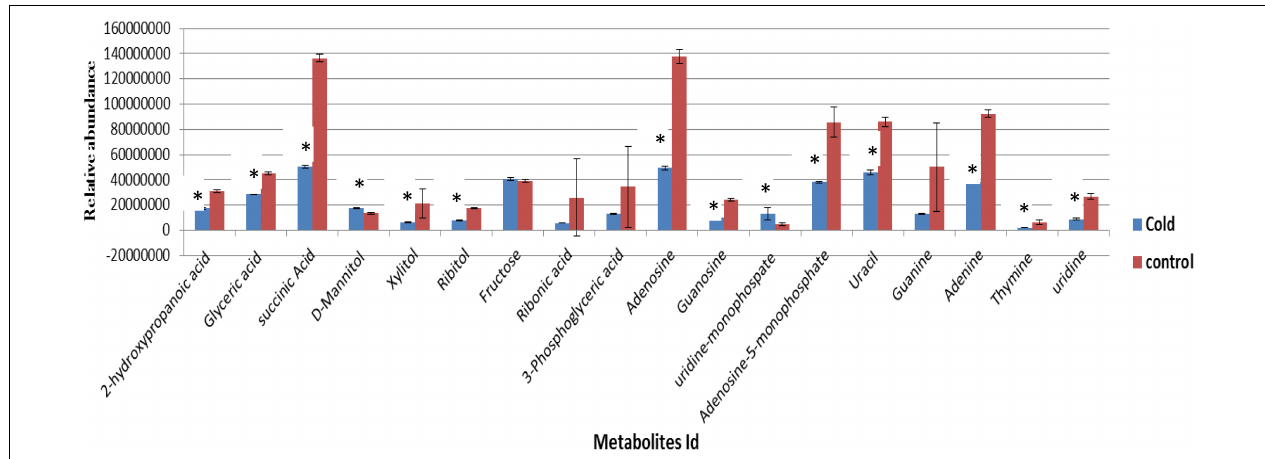
FIGURE 1 | The relative abundances of cytoplasmic metabolites extracted from the cells grown to a mid-exponential phase of growth at 37 ◦ C (control, n = 4) compared with equivalent sets of the cells that were subsequently exposed to lower temperature of 4 ◦ C (Cold, n = 4) (mean ± SD, p < 0.05). ∗ Significantly altered